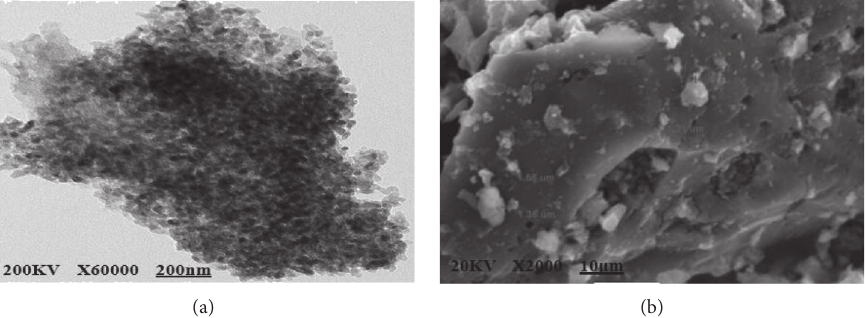
Figure 2: (a) TEM and (b) SEM images of the adsorbent.